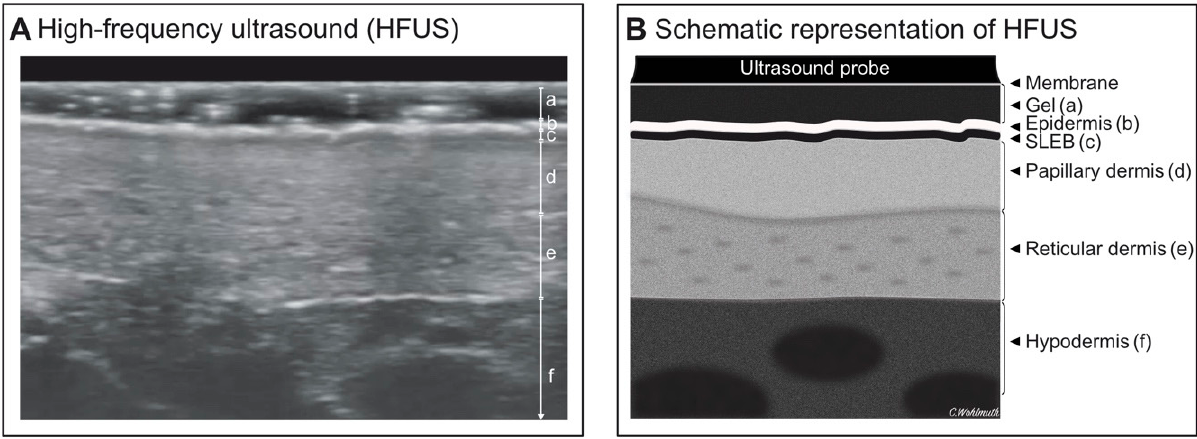
Figure 2. ( A , B ): Assessment of CTCL using HFUS. ( A ): High-frequency ultrasound image obtained in a CTCL patient depicting the epidermis (b), SLEB (c), papillary dermis (d), reticular dermis (e) and hypodermis/subcutis (f). ( B ): Schematic representation of the skin in high-frequency ultrasound images. Abbreviations: CTCL, cutaneous T-cell lymphoma; HFUS, high-frequency ultrasound; µm, micrometer; SLEB, subepidermal lower echogenic band. Table 3. High frequency ultrasound measurements.